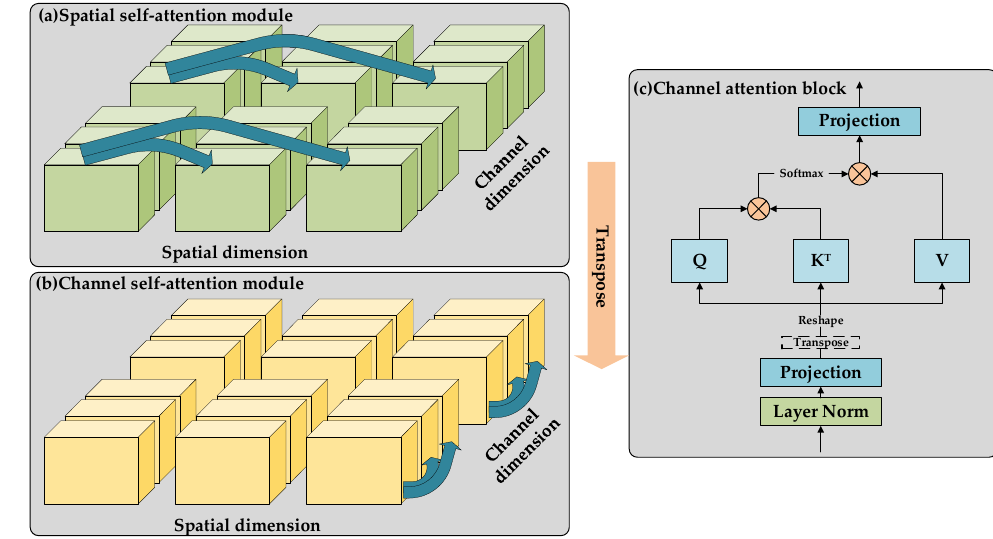
Figure 4. Architecture of the dual-attention encoders: ( a ) Spatial self-attention module, ( b ) channel self-attention module, and ( c ) channel attention block.